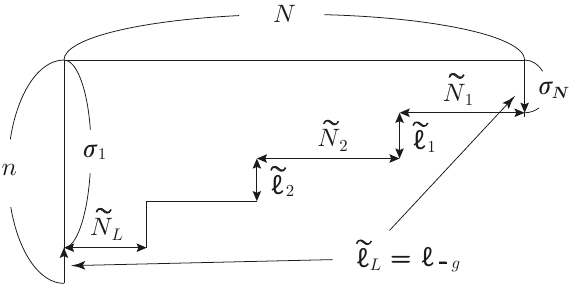
Figure 2 . The (cid:12)nite sequence (3.20), where we follow the notation in footnote